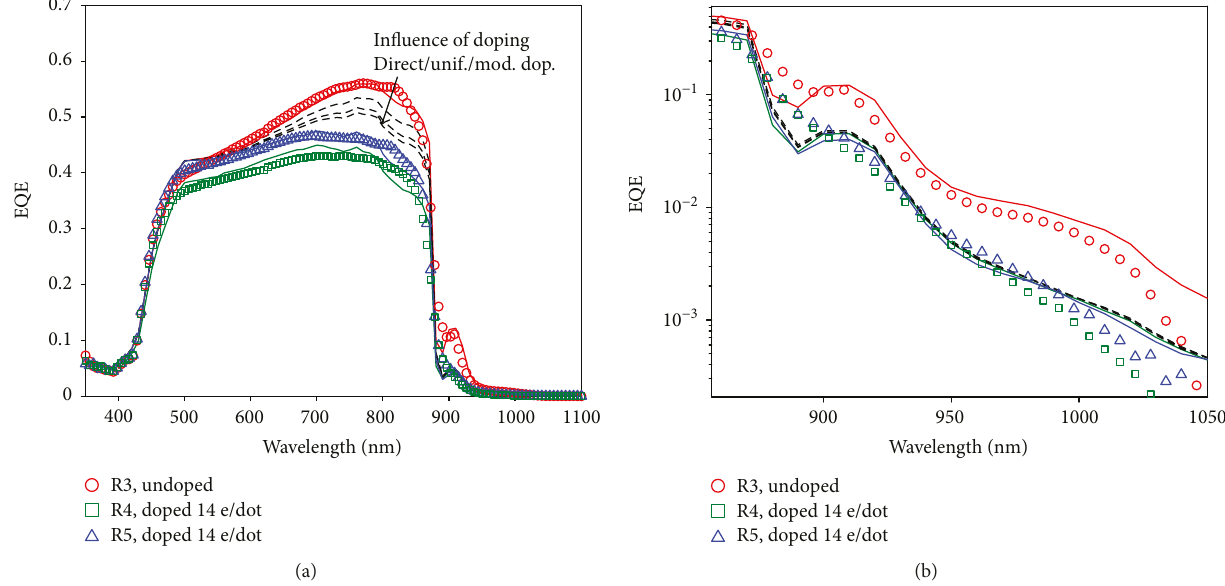
Figure 4: (a) Comparison between measured and simulated EQE. (b) Zoom in the QD wavelength region. The black dashed lines show the predicted decrease of EQE according in the doped (14 e/dot) QD solar cell assuming the same minority carrier lifetime as in the undoped sample and under di ff erent hypotheses of dopant impurity distribution: well con fi ned in the QD region (direct), uniformly distributed across the QD stack, and located at the center of the GaAs interdot layers. Symbols show experimental data. Solid lines inidicate simulation and best fi t.